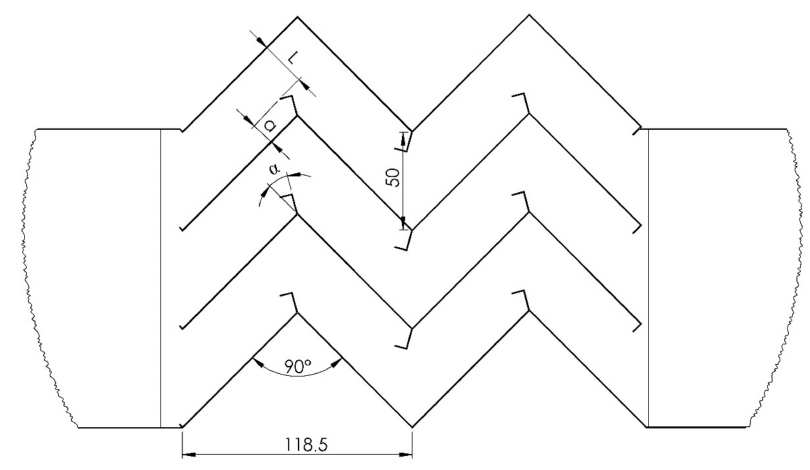
Figure 3. Details of geometries of analysed wave-plate mist eliminators dimensions in